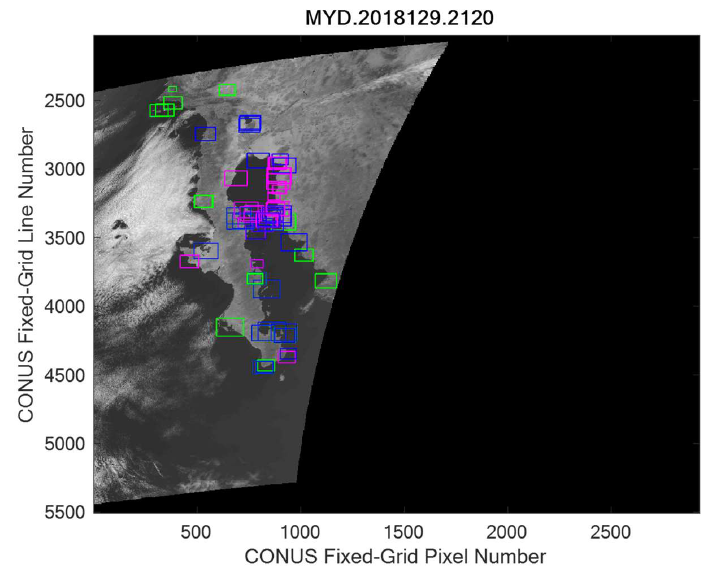
Figure 16. The performance assessment tool set (IPATS) Landsat 8 templates can measure any residual geometric error in the remapped MODIS granule. The outlines are color-coded in accordance with the normalized cross correlation (NCC) peak value (magenta > 0.95, blue > 0.9, and green >